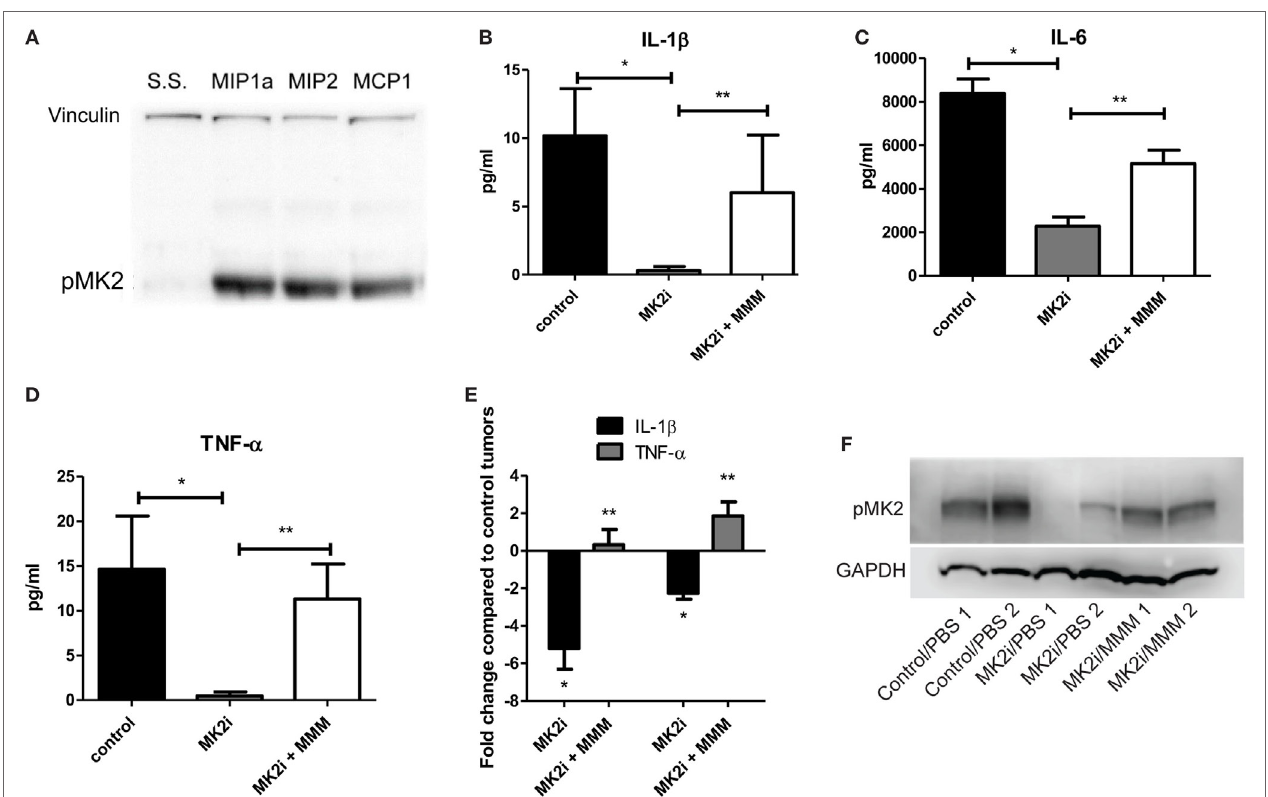
FigUre 3 | MCP-1, Mip-1 α , and Mip-2 α (MMM) activate MK2 signaling and downstream cytokine expression in colon cancer cells. CT26 cells treated with MMM induce (a) MK2 phosphorylation. MK2i treatment inhibits (B) IL-1 β , (c) IL-6, and (D) TNF- α in tumor supernatants, but this effect is reversed upon addition of MMM when examined by multiplex cytokine array. (e) Additional mRNA data for IL-1 β and TNF- α since the protein level is low support the increase in cytokine gene expression. (F) MK2 is also phosphorylated in CT26 tumors, is decreased at day 13 in tumors treated with MK2 inhibitor, and is restored by addition of MMM in tumor treated with MK2 inhibitors. N = 7–8 for tumors, * and ** p ≤